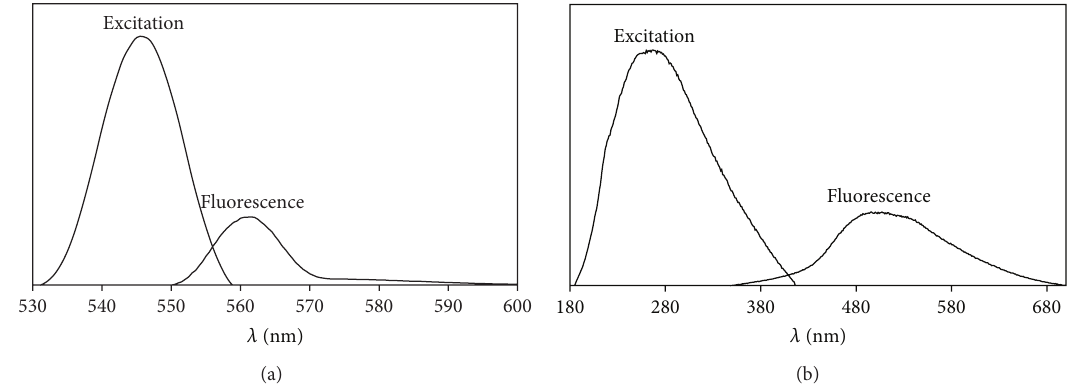
= 544 nm) and (b) 2 ( 𝜆 ex